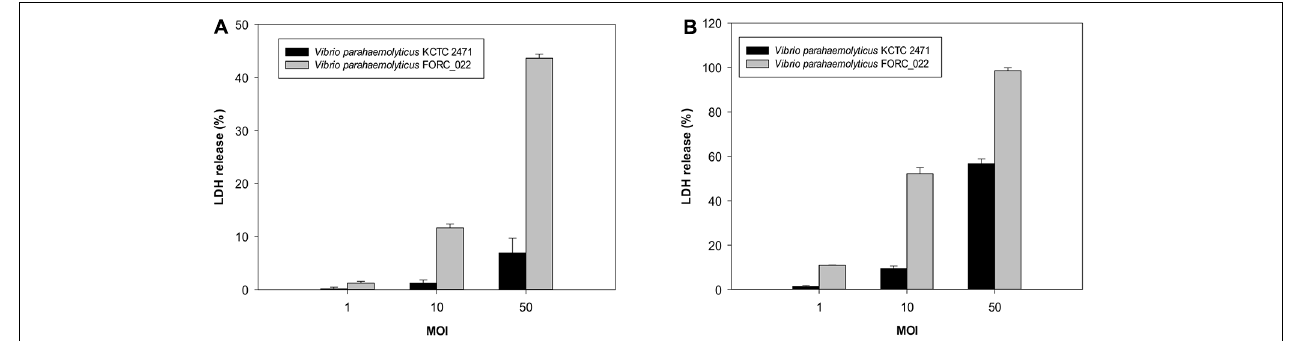
FIGURE 1 | Cytotoxicity analyses of the FORC_022 strain were compared with the KCTC 2472 strain by measuring the activity of cytoplasmic lactate dehydrogenase (LDH). INT-407 cells were infected with FORC_022 or KCTC 2471 at various multiplicities of infection (MOIs) for (A) 2 h and (B) 3 h. Cytotoxicity was determined as the percentage of LDH leakage using the amount of LDH from the cells that were completely lysed by 2% Triton X-100. Error bars represent the standard errors of the means.